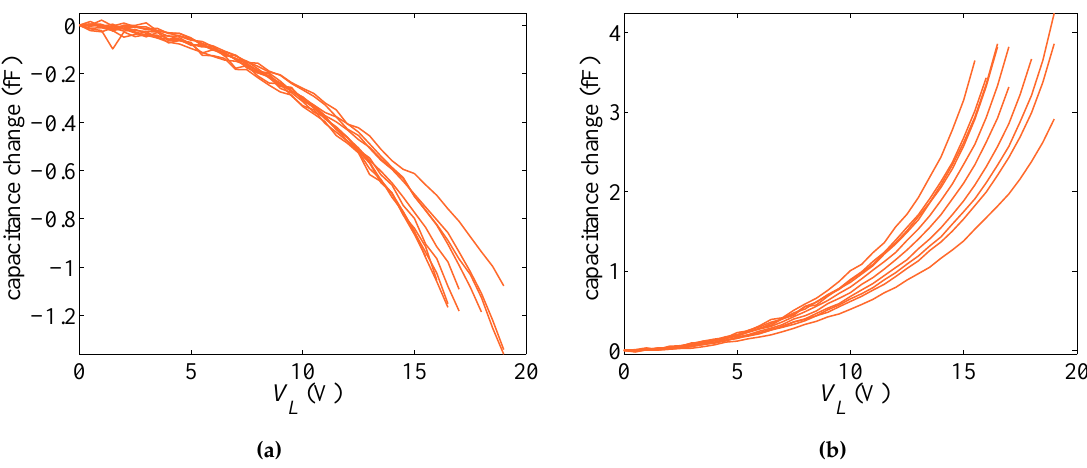
Figure 2. Rotational actuation through V R : experimentally-measured capacitance change with ( a ) rotational sensing and ( b ) lateral sensing.